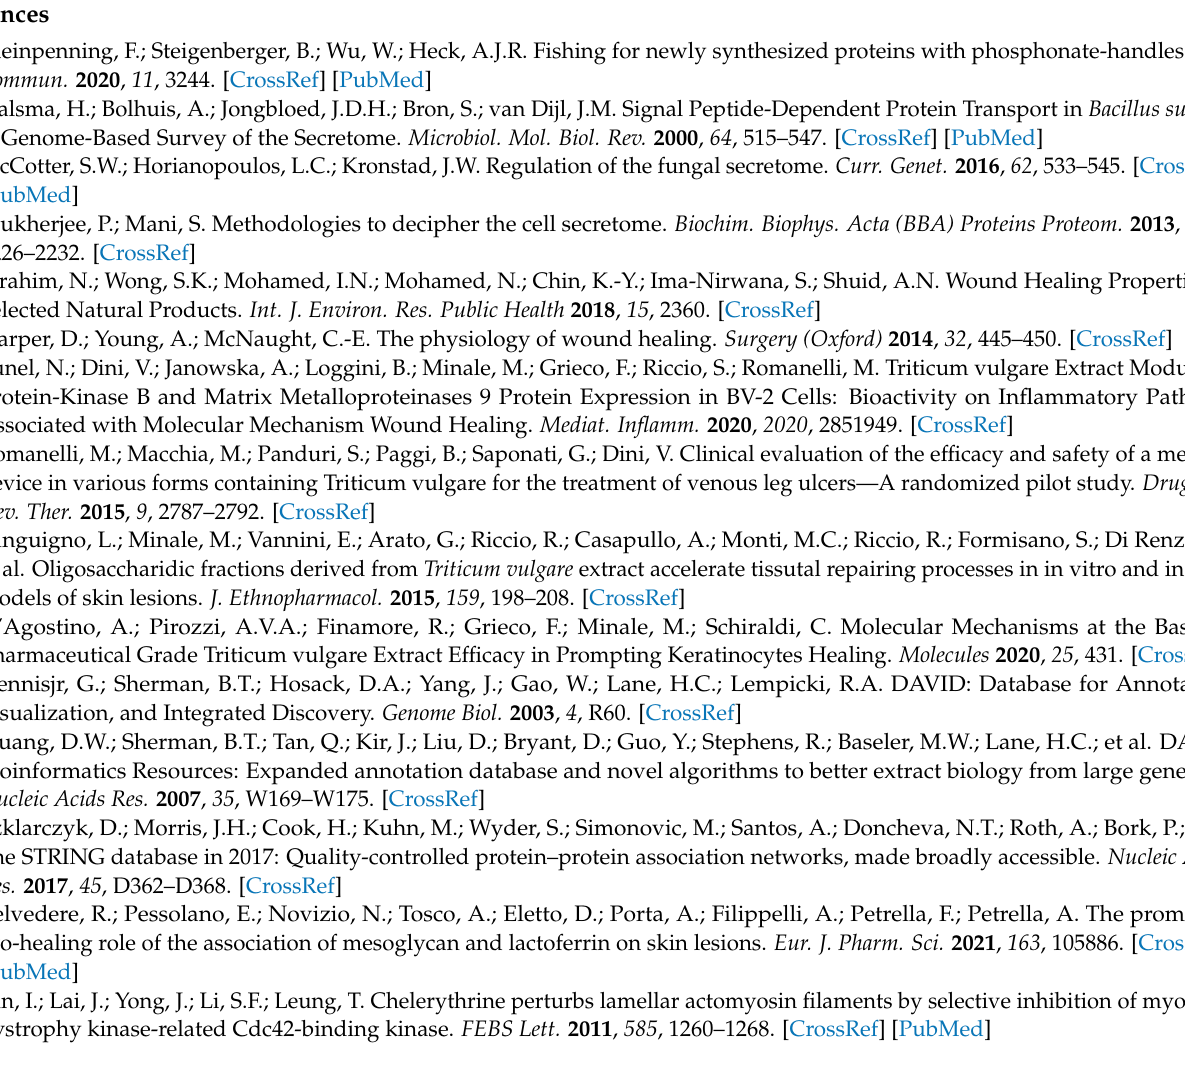
Supplementary Materials: The following are available online: Table S1: list of the 2529 identified and quantified proteins. Figure S1: Venn diagram of unique and common proteins identified in HaCat cell secretomes treated or not with TVE. Figure S2: uncropped western blotting analysis reported in Figure